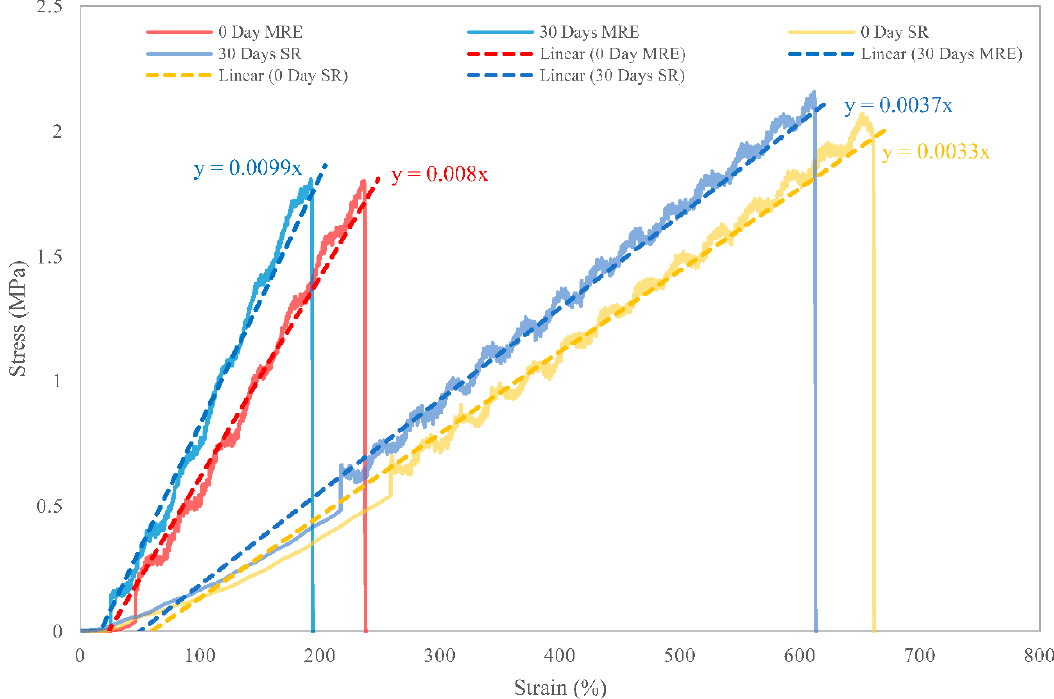
Figure 4. Stress–strain curves of SR and MRE samples, before and after 30 days of natural weathering exposure, and linear regression on the increment